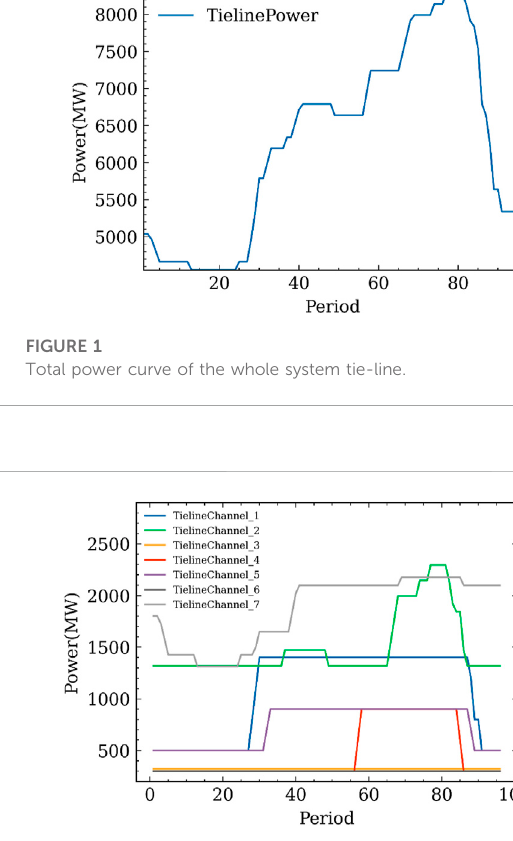
FIGURE 2 Power curve of seven tie-line groups.